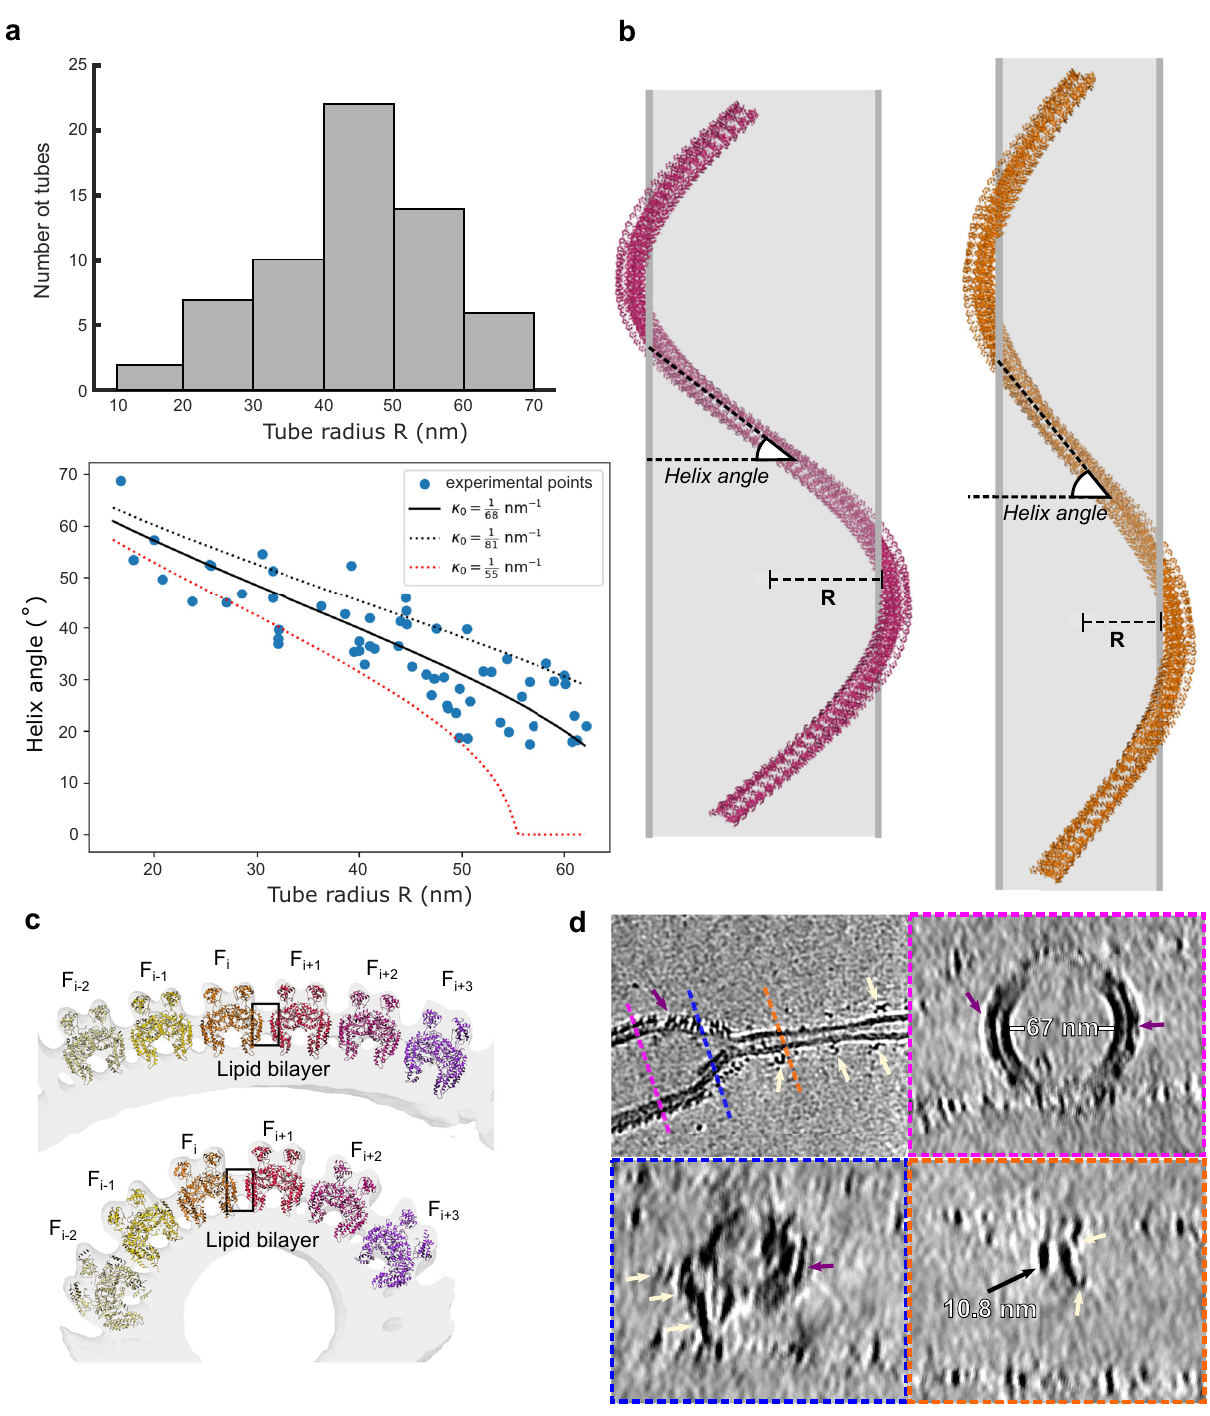
Fig. 5 | EHD4 fi laments adapt to the curvature of membrane tubes. a Distributionoftuberadius(top)andtherelationoftuberadiusandorientationof the fi lament along the tube axis (bottom). Solid line shows the best fi tting spon- taneous curvature (see Methods).Dotted lines show the limiting range toillustrate the con fi dence in predicting κ 0 . b EHD4-covered membrane tubes show various assemblies. A single fi lament is depicted around the lipid tube (gray). The average helicalassemblyofthemembrane-boundEHD4structureisrepresentedontheleft and the tube with the smallest diameter is depicted on the right. Both fi laments